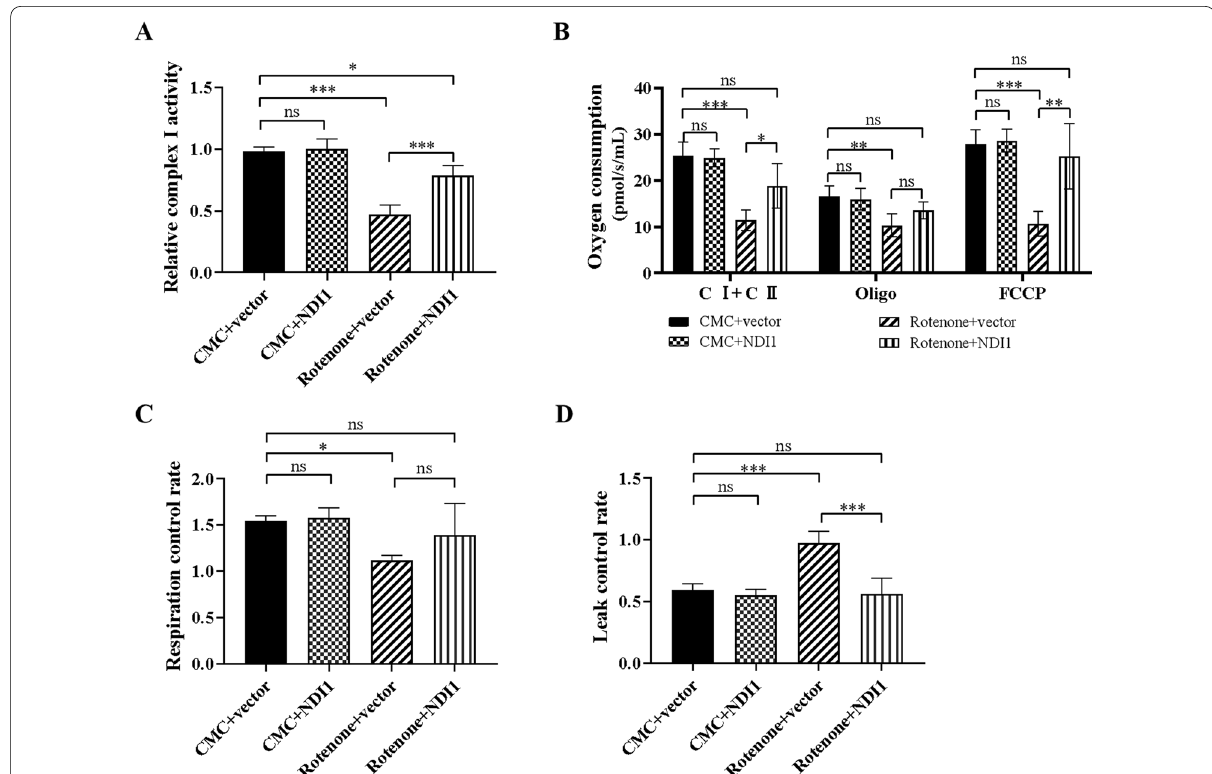
Fig. 9 The mitochondrial oxidative phosphorylation function in right substantia nigra of rotenone-induced PD mouse model transduced with NDI1. A The mitochondrial complex I enzyme activity was determined by measuring the NADH oxidation rate using a spectrophotometer. B The total oxygen consumption of mitochondrial complexes I and II (C I C II), ATP synthase uncoupling oxygen consumption after oligomycin + treatment (Oligo), and maximum oxygen consumption after FCCP treatment (FCCP) were detected using a cellular respiration apparatus. C RCRs (respiratory control rates) were calculated as (C I C II)/Oligo. D LCRs (leakage control rates) were calculated as Oligo/FCCP. Rotenone vector + + group compared with DMSO vector group, or Rotenone NDI1 group compared with Rotenone vector group, or Rotenone NDI1 group + + + + compared with DMSO vector group, ns not significant, * P < 0.05, ** P < 0.01, *** P < +